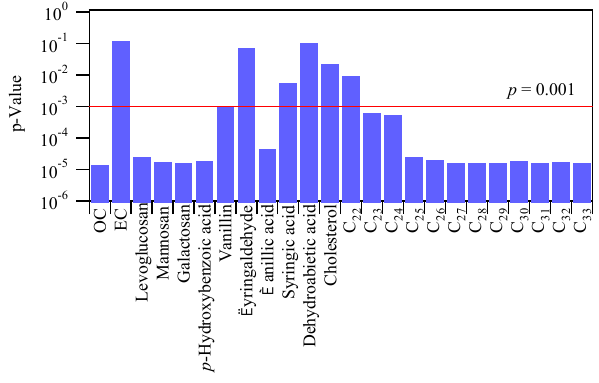
Figure 6. P values to determine significance in the two-sided Wilcoxon rank sum test between the IPF and other